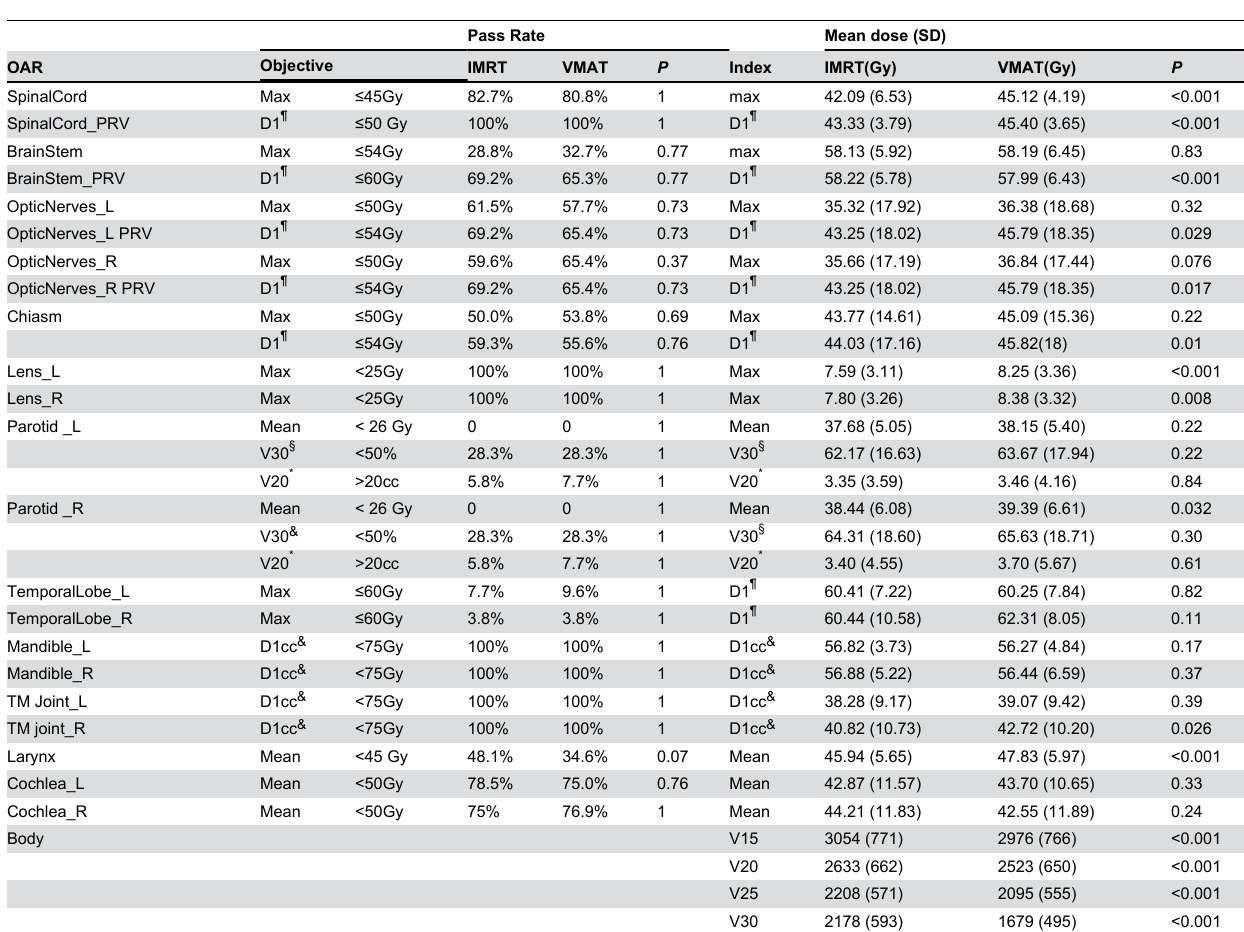
Table 2. Dosimetric comparison of VMAT and IMRT for the organs at risk (OARs) in 52 NPC patients.